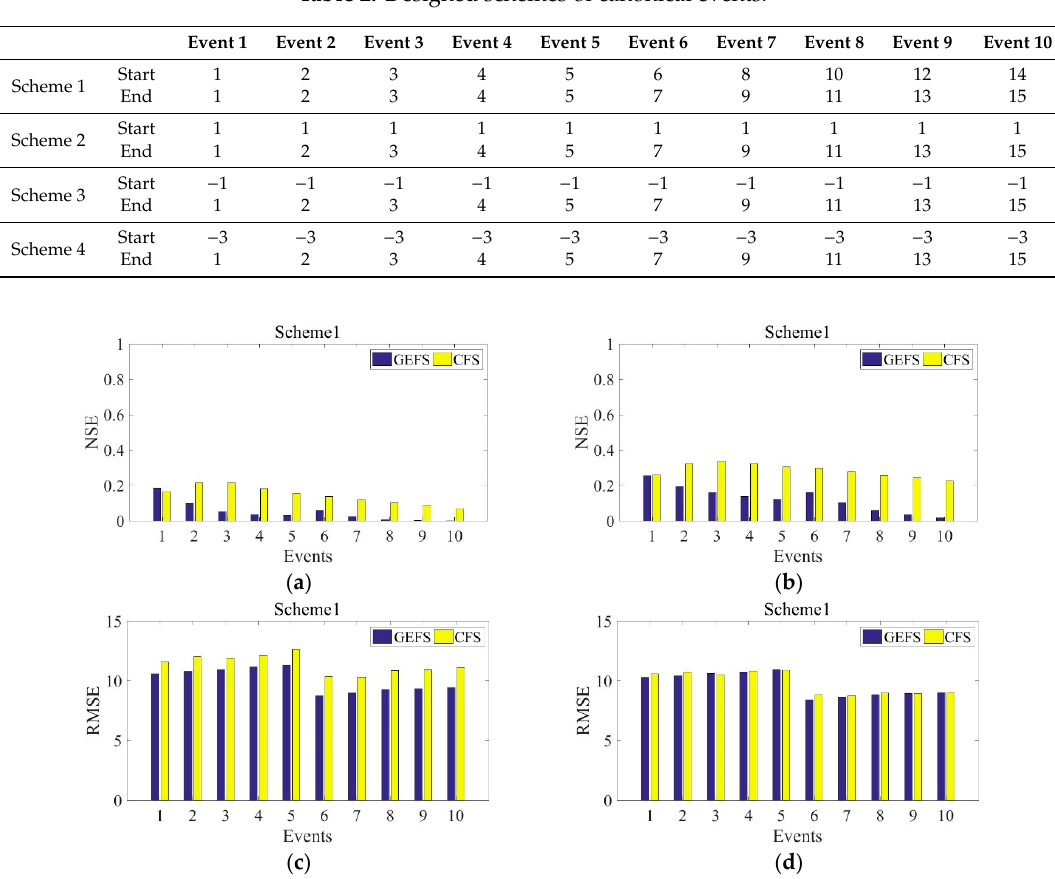
Figure 4. The evaluation results of Scheme 1: ( a ) the NSE of raw forecasts; ( b ) the NSE of post-processed forecasts; ( c ) the RMSE of raw forecasts; and ( d ) the RMSE of post-processed forecasts.